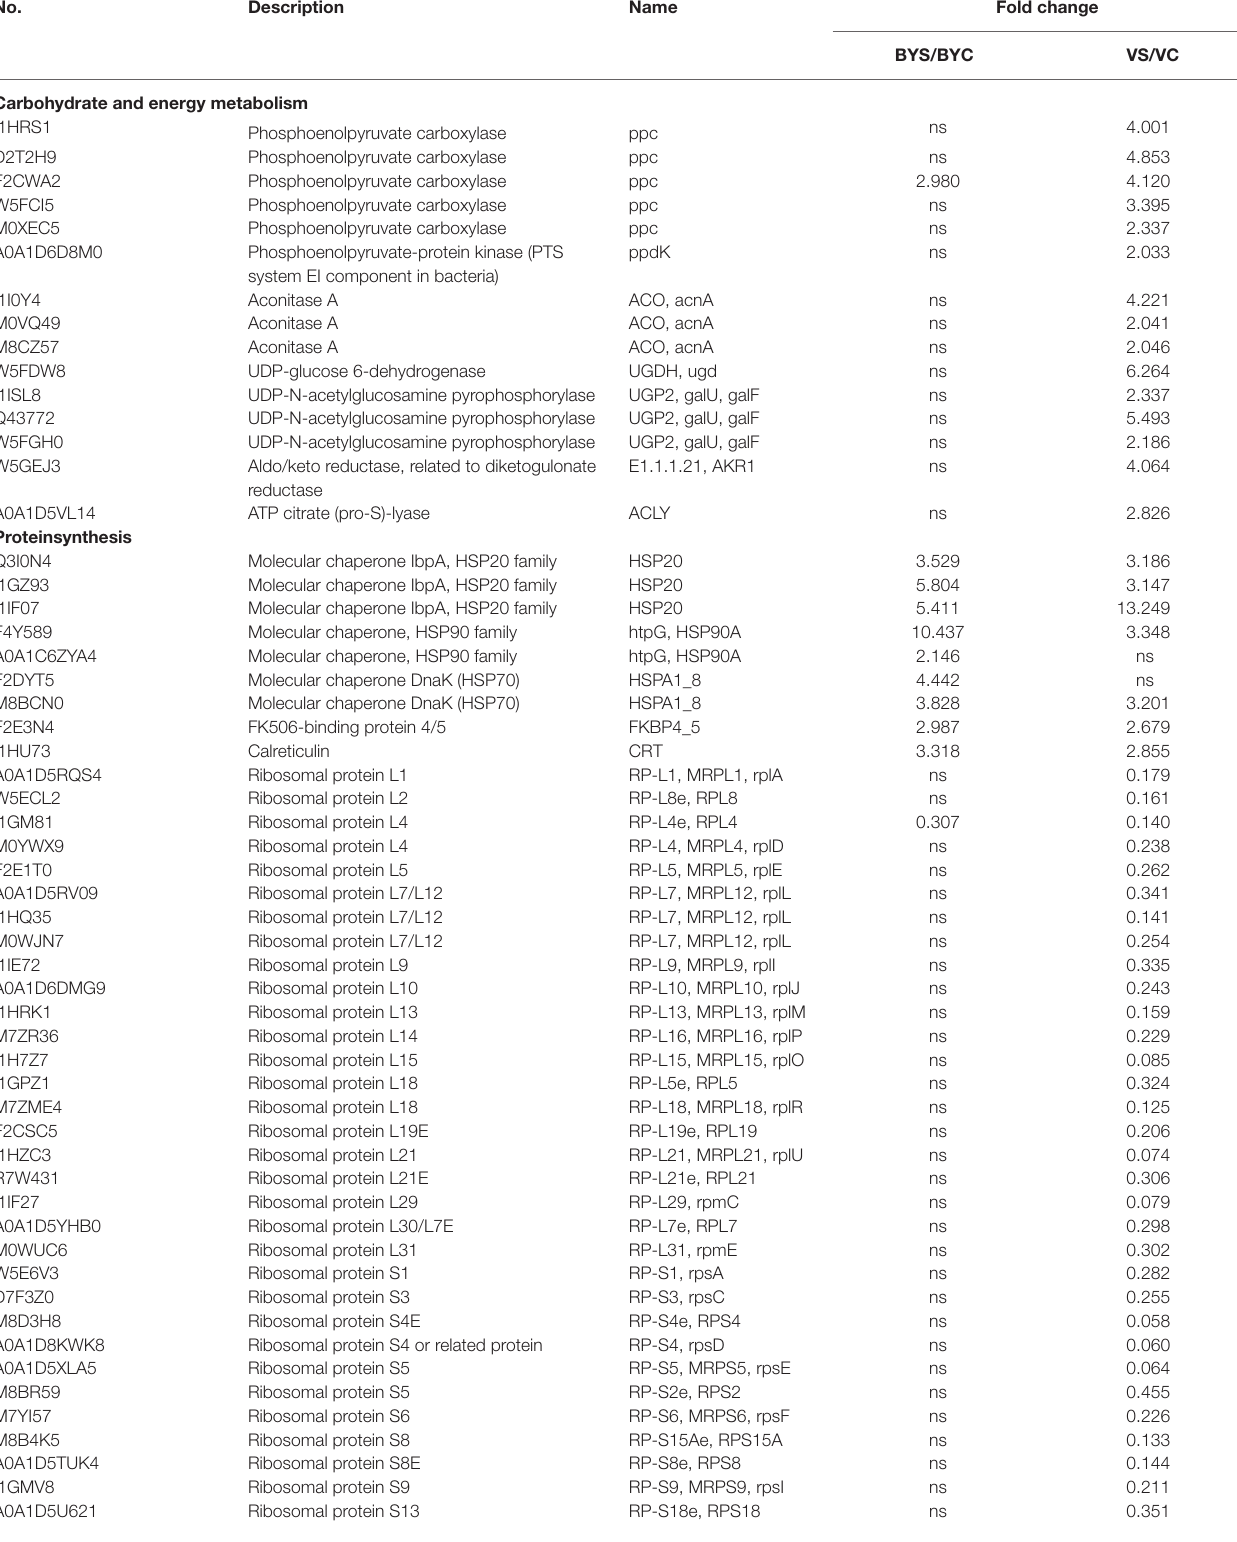
TABLE 4 | The candidate DEPs from main functional categories in Bai5 and Vao-9.